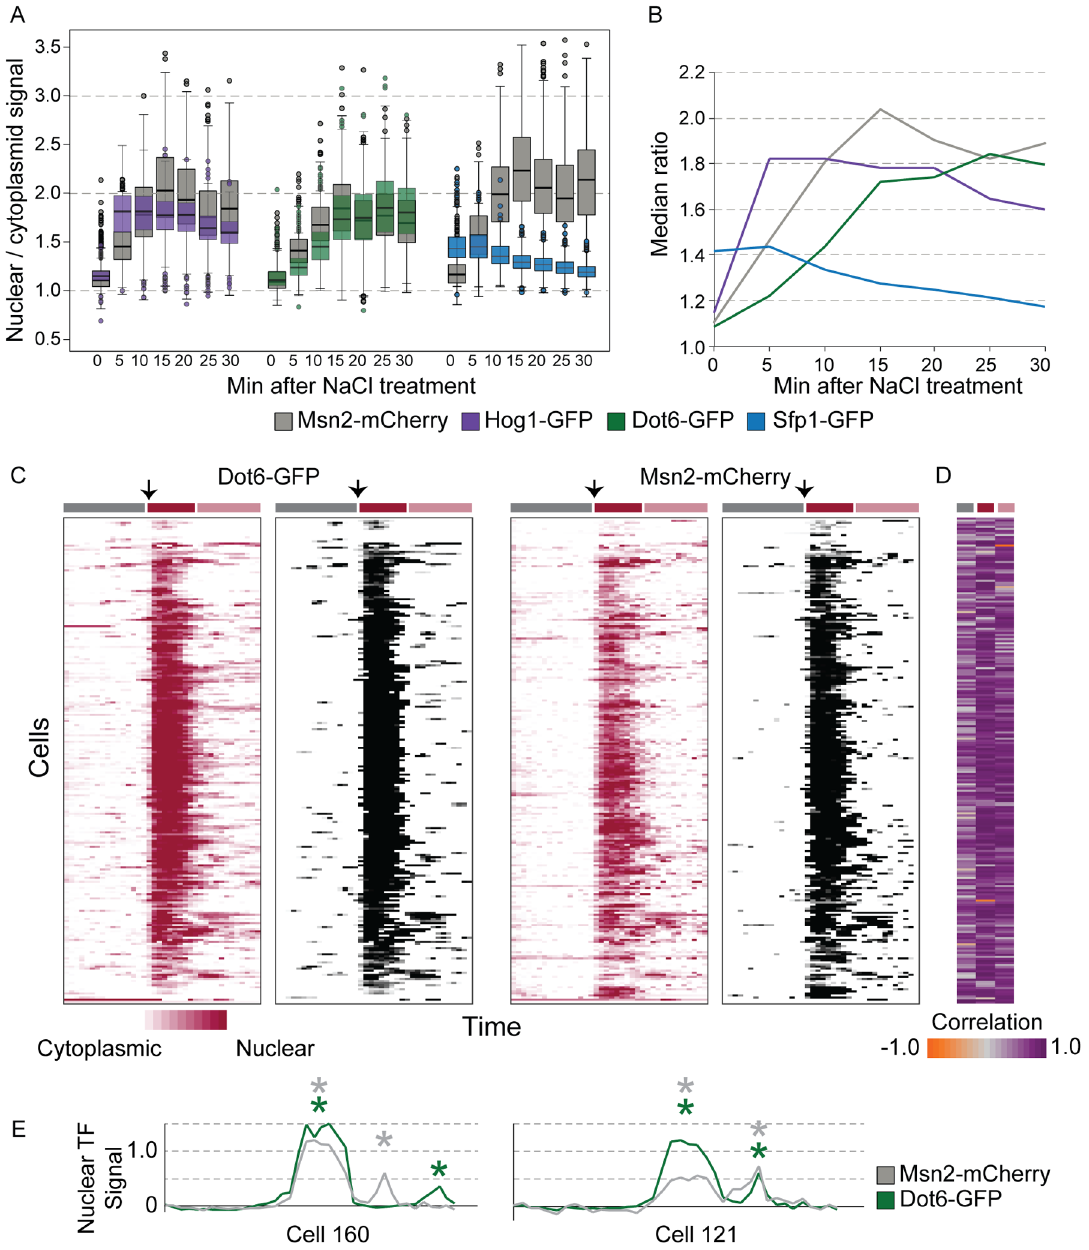
Fig 7. Stress-activated regulators show both coordinated and decoupled nuclear localization. (A) Distributionof nuclear/cytoplasmic signal for pairedfactors in individualcells before and after NaCl treatment (average n = 676 cells per time point). Data from two biological replicates were very similar and combined(S11 Table). (B) Median ratios from (A) plotted over time; the Msn2 plot combinesmeasurements from all three strains. (C) NuclearTF signals(see Methods)of Dot6-GFP (left) and Msn2-mCherry (right) expressedin the same cells over time, before stress and after NaCl additionat 81 min (arrows). Each row alignedacross all plots represents a different cell, and each column represents a different time point. Red plots show traces of nuclearlocalizationaccordingto the key (see Methods), and correspondinggrey-scaleplots show quantitative measurements only for time points called as peaks. Coloredboxes above the plots indicate 80 min before stress (grey box), 30 min after NaCl treatment (dark red box), and beyond30 min after NaCl treatment (pink box). Data are availablein S12 Table. (D) CorrelationbetweenDot6-GFP and Msn2-mCherry traces for each temporalphase, accordingto the key. (E) Representative traces from (C), where called peaks (coloredaccordingto key) are indicatedwith asterisks. TF, transcription factor.